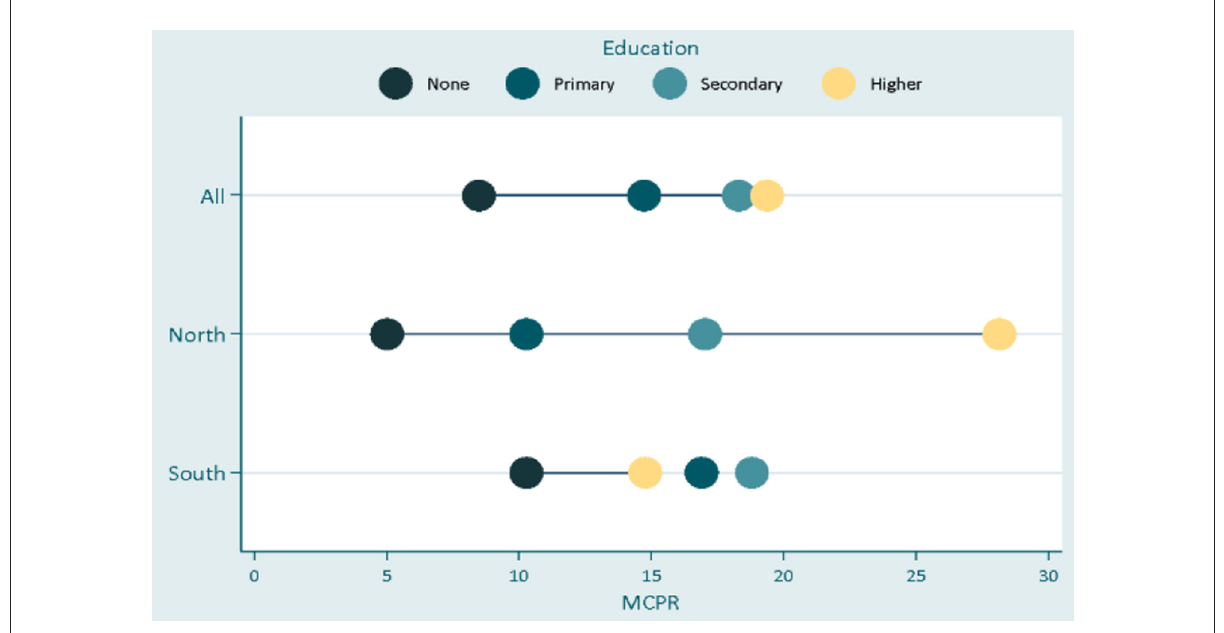
FIGURE1 Inequalities in contraceptives uptake by